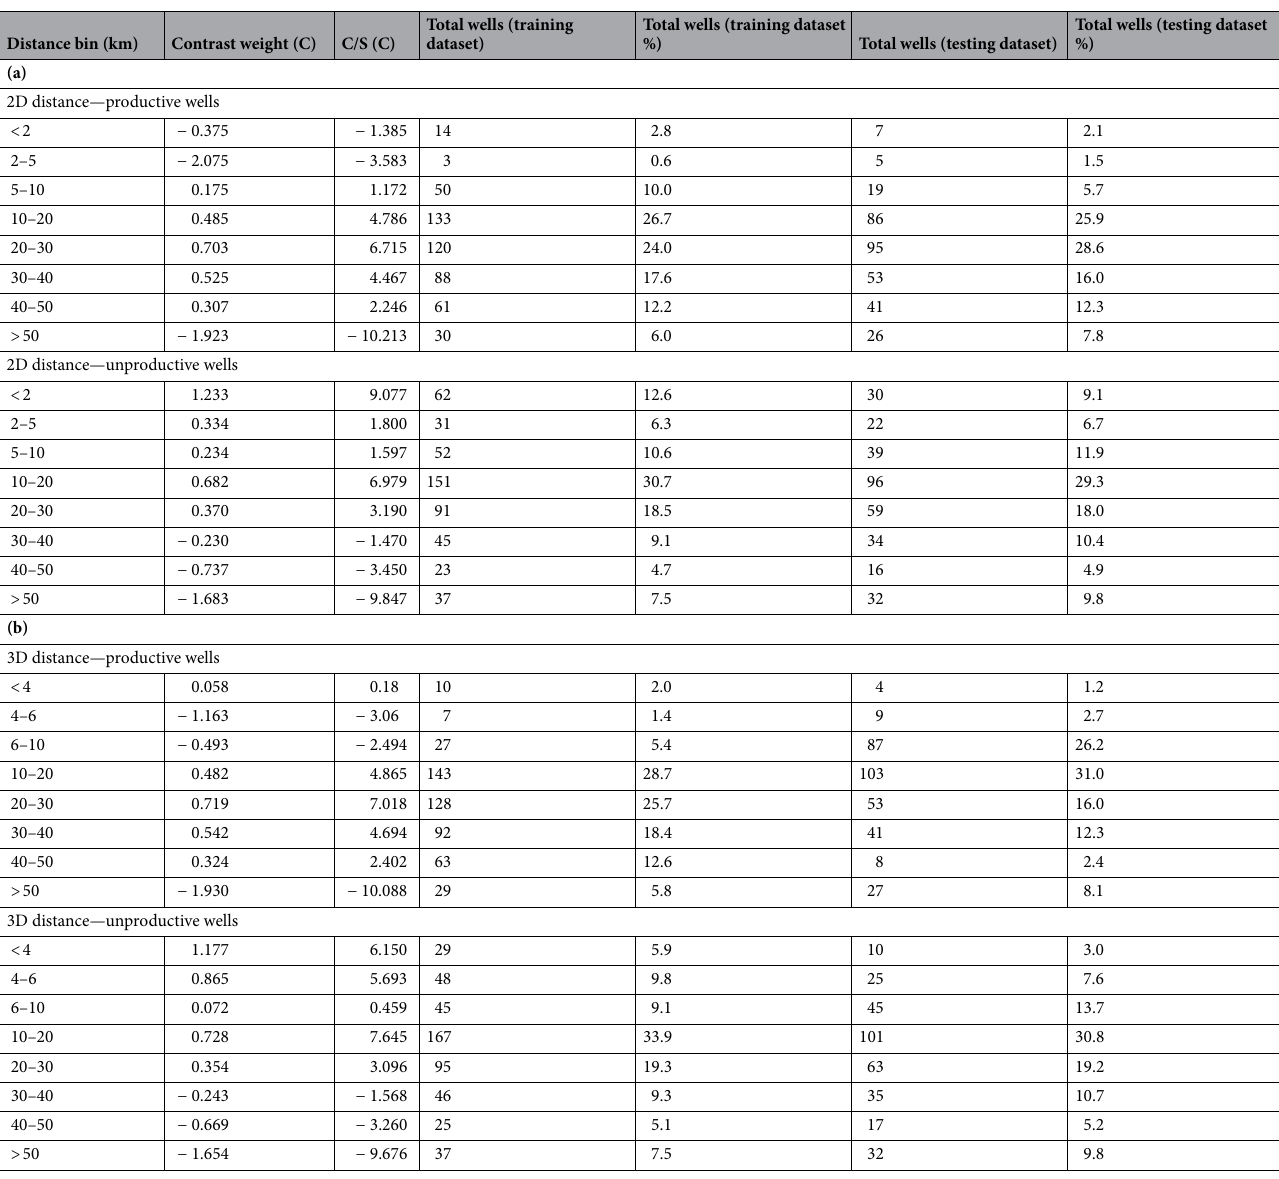
Table 2. Summary of the results obtained through the Weight of Evidence test. Summary of the results obtained for the 2D (a) and 3D (b) distance scenarios, respectively for productive and unproductive